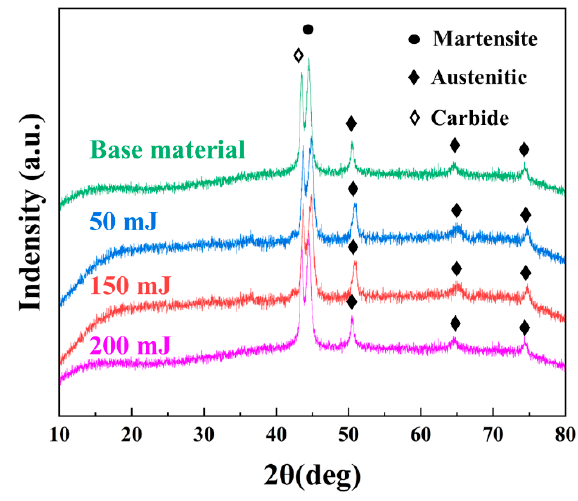
Figure 8. XRD patterns after different energy treatments.